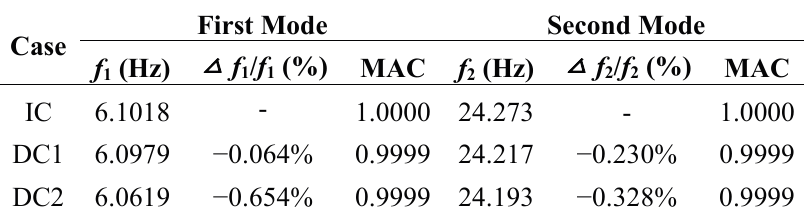
Table 2. Changes in modal parameters due to